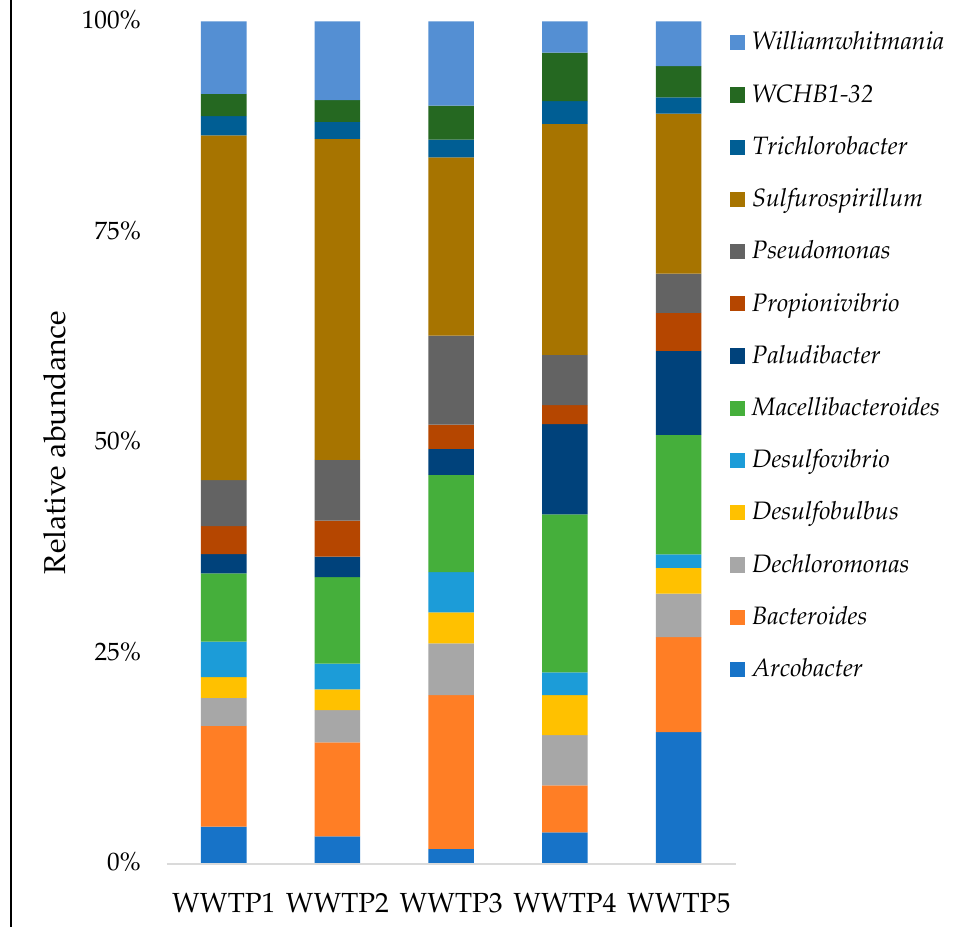
Figure 4. Relative abundance of predominant genera across the five WWTPs.